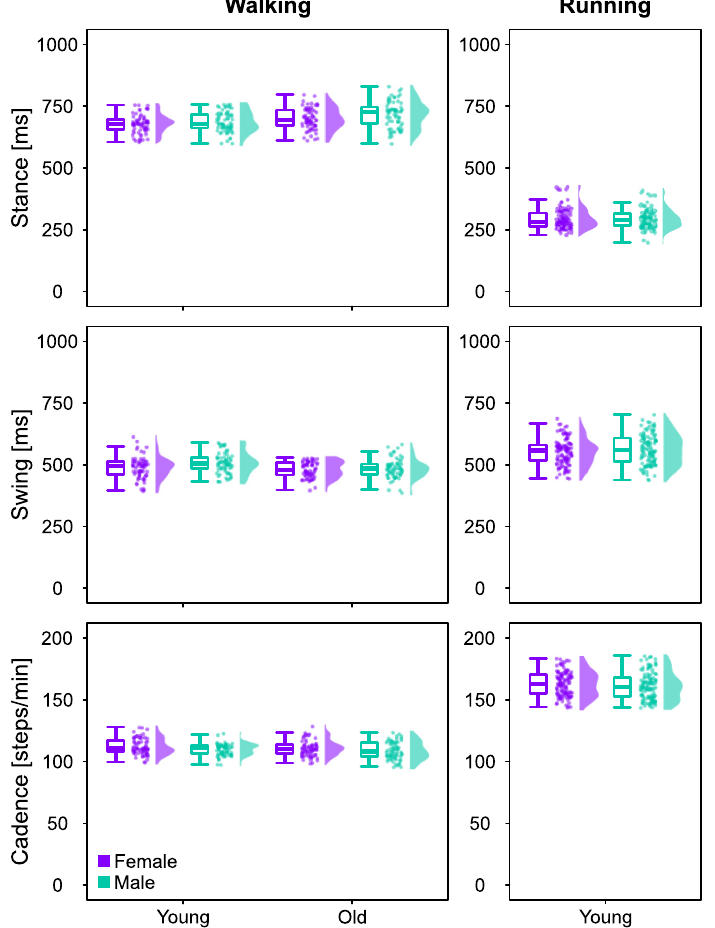
Fig 1. Gait temporal parameters. Boxplots describing the three gait temporal parameters stance duration, swing duration and cadence for the three investigated groups, calculated from walking or running. Raw data points (dots represent the mean value of 30 gait cycles from every participant) and their density estimates are presented to the right side of each boxplot.